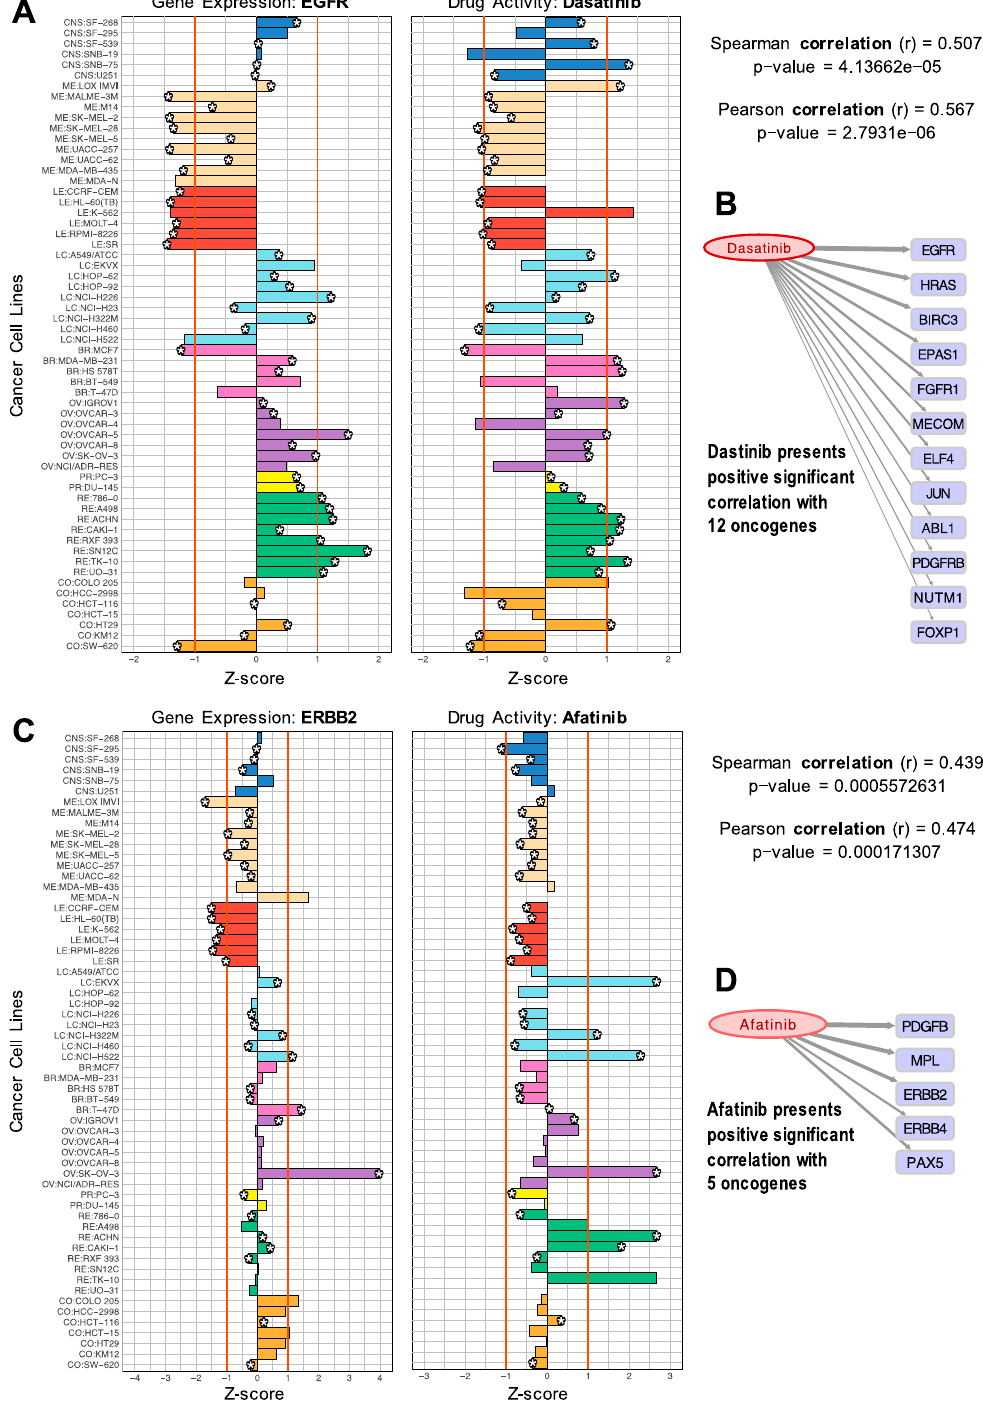
Figure 1. Comparison of gene expression versus drug activity (normalized profiles) to find significant correlations: ( A ) EGFR gene versus Dasatinib; ( B ) positive significant correlations of Dasatinib with 12 oncogenes; ( C ) ERBB2 versus Afatinib; ( D ) positive correlations of Afatinib with five oncogenes.